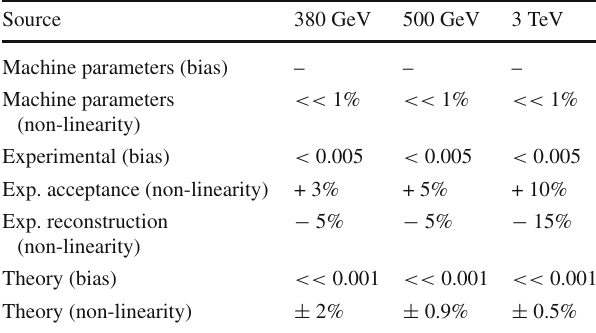
Table 7 The main systematic uncertainties on the asymmetry A Re for left-handedpolarizedelectronbeam(andright-handedpositronbeamin thecaseof500GeVoperation).Entrieslabelled bias representestimates of upper bounds on systematic effects that yield a spurious non-zero result in the Standard Model. Entries labelled non-linearity represent systematicuncertaintiesthataffecttheproportionalityoftheresponseto non-zero values of the asymmetry (induced by physics beyond the Stan- dard Model). Positive signs indicate effects that enhance the observed asymmetry. Negative signs correspond to effects that dilute the